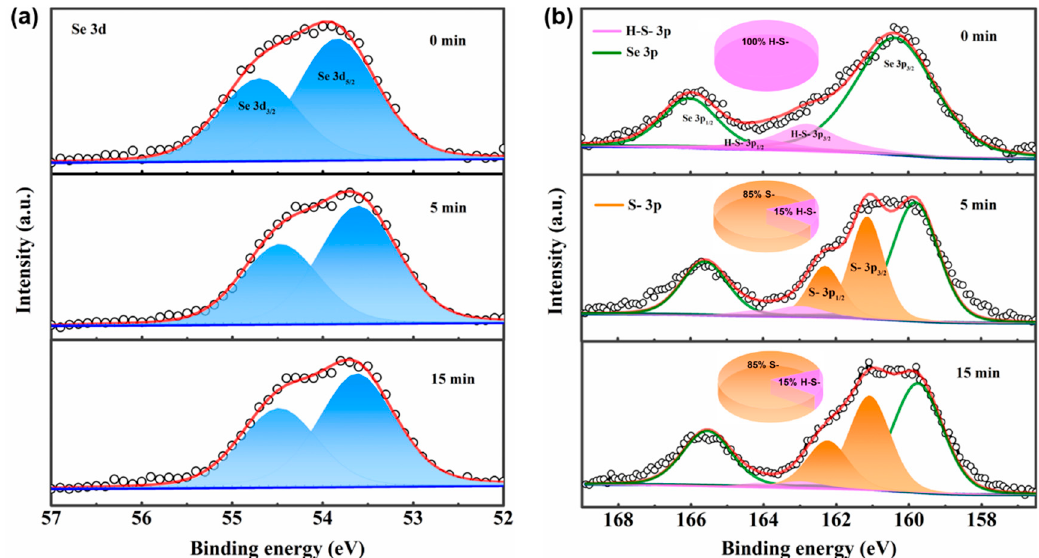
Figure 4. XPS spectra of ( a ) Se 3d and ( b ) S 3p of the TiO 2 / ZnSe NR photoanodes passivated with sulfur for 0, 5, and 15 min. These XPS spectra offer insights into the chemical state evolution of Se and S bonds during the atomic sulfur passivation, which were made into pie charts to demonstrate the ratios of S from the 3-MPA ligand ( H-S- ) and in ZnS ( S- ). Raw intensity of Se and S (pancyclic line graphs) and peak sums of Se and S (red lines) are also provided.